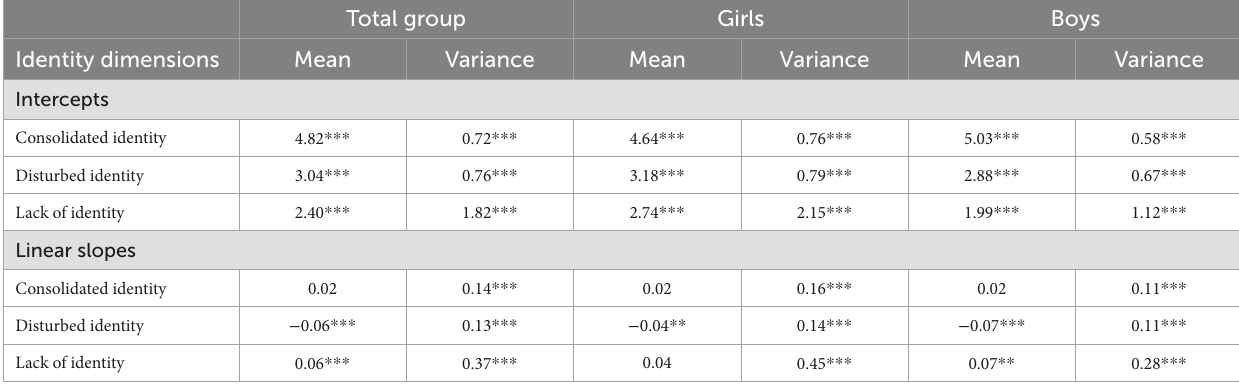
TABLE 3 The mean and variance of intercepts and slopes for identity